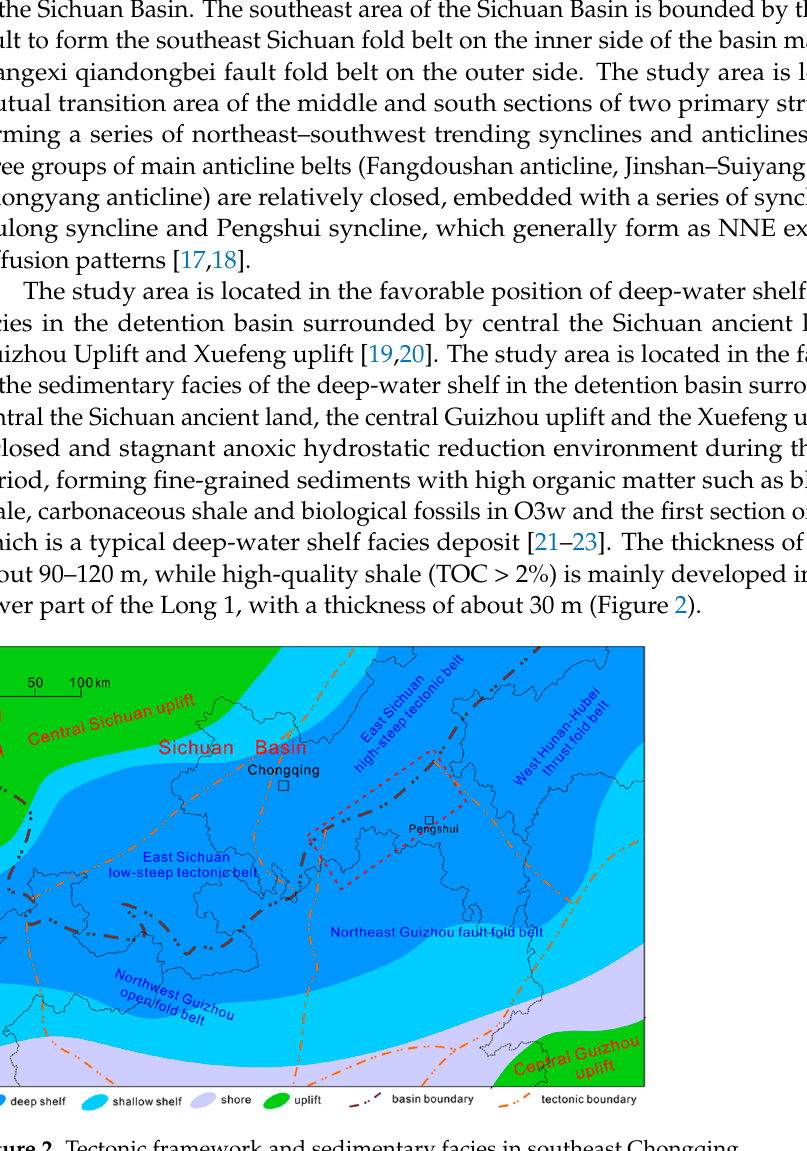
Figure 2. Tectonic framework and sedimentary facies in southeast Chongqing.